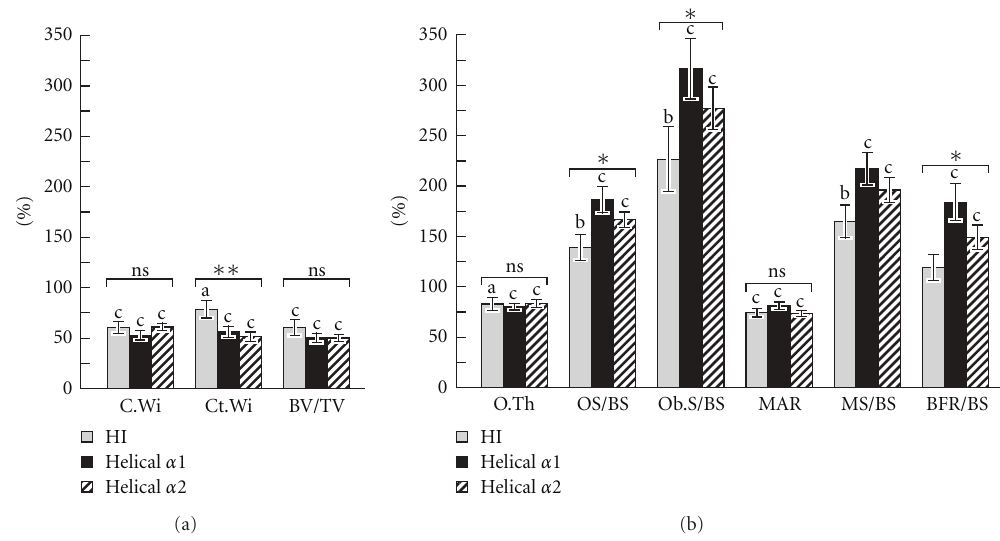
Figure 4: Iliac bone histomorphometric results in patients with COL1A1 haploinsu ffi ciency mutations (HI), as well as with COL1A1 and COL1A2 mutations leading to glycine substitutions in the helical domain of collagen type I. Results are expressed as a percentage of the average result in the age-specific reference range [14]. The letters above the bars indicate the significance of the di ff erence from 100% (i.e.,